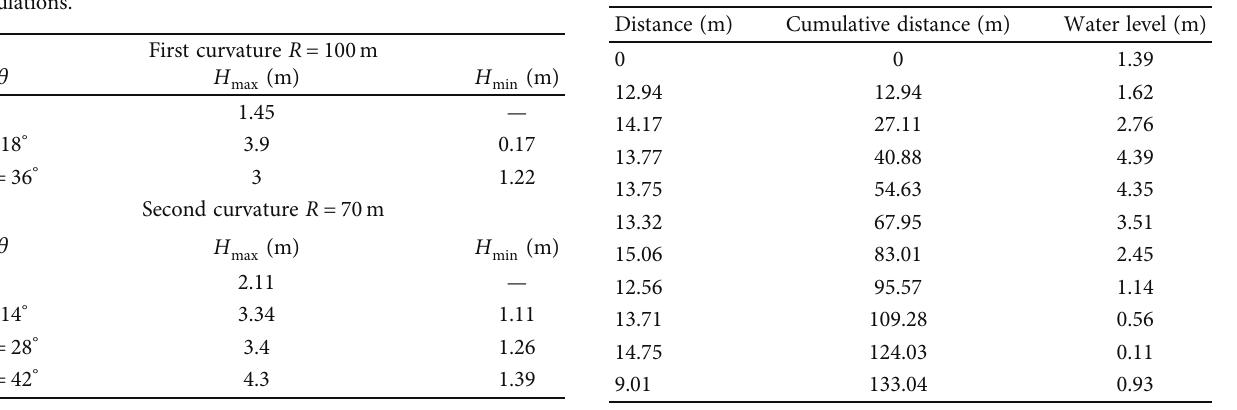
Table 7: Right water level-physical